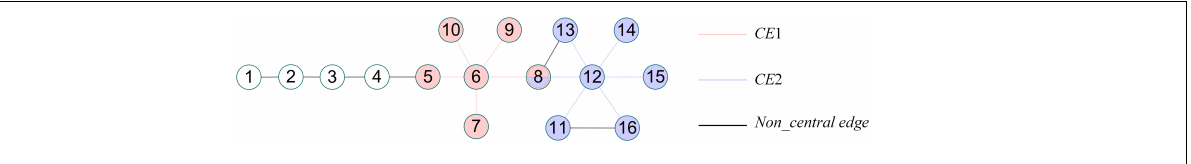
FIGURE 1 | A simple